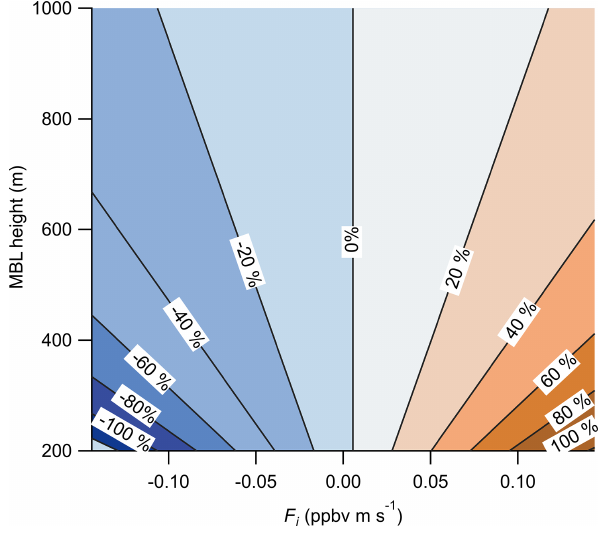
Figure 12. Calculated percent error in the measured O 3 surface flux due to entrainment from the free troposphere as a function of the MBL height and the entrainment flux ( F i ). Entrainment flux is the product of the free-troposphere-to-boundary-layer concentra- tion gradient ( (cid:49)C ) and the entrainment velocity ( w e ). Calculation of the percent error used the Scripps Pier measuring height of 13m and mean surface flux of − 5 . 6 × 10 − 3 ppbvms − 1